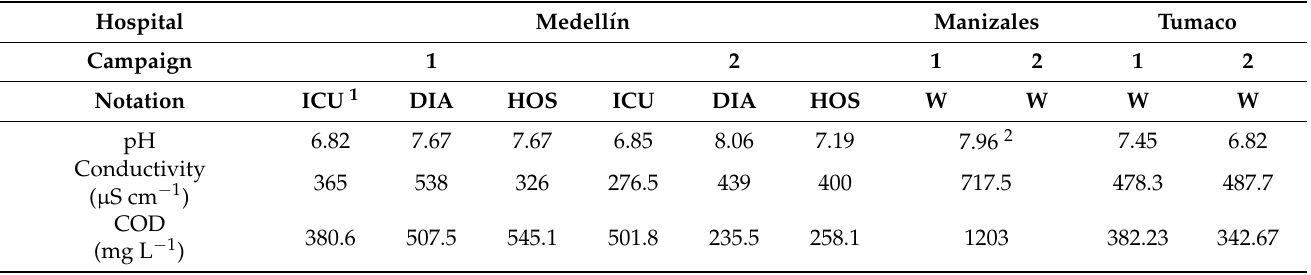
Table 1. Characterization of the samples through relevant wastewater quality